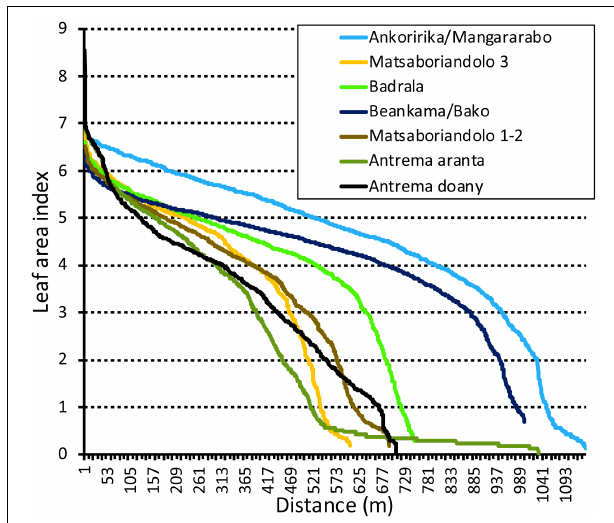
FIGURE 2 | LAI profile in different forest sites. For each profile, LAI values measured every 1 m along a transect are arranged by decreasing values (the x-axis shows the cumulative distance walked in each transect). The steepness and inflexion of the slope indicate the gradient from discontinuous to continuous canopy or disturb vs. undisturbed forest area. For instance, the steep slope of the Antrema doany profile reflects transitions from patches of old mango trees and cultivated fruit tree plots to relatively open fields and gaps while Ankoririka forest shows a more homogenous forest cover.